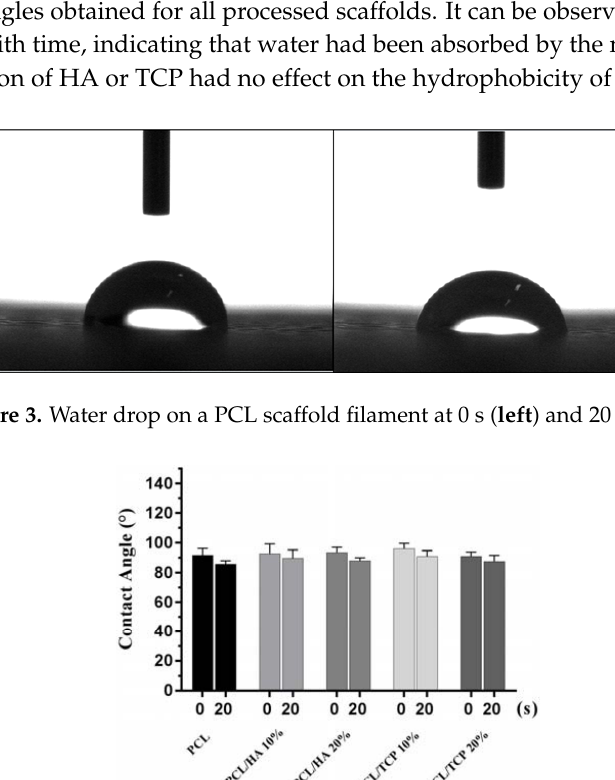
Figure 4. Contact angles obtained for all processed scaffolds at 0 s and 20 s, respectively.